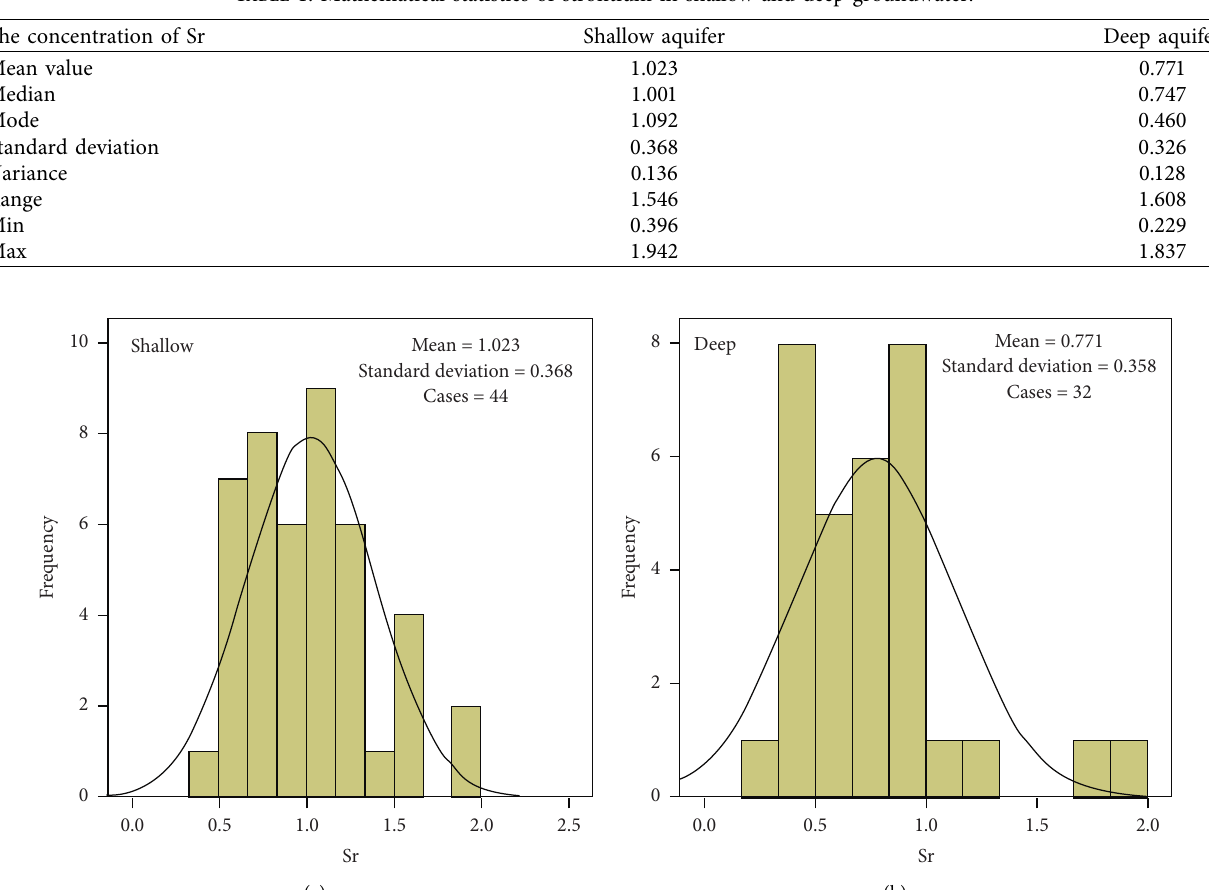
Table 1: Mathematical statistics of strontium in shallow and deep groundwater.